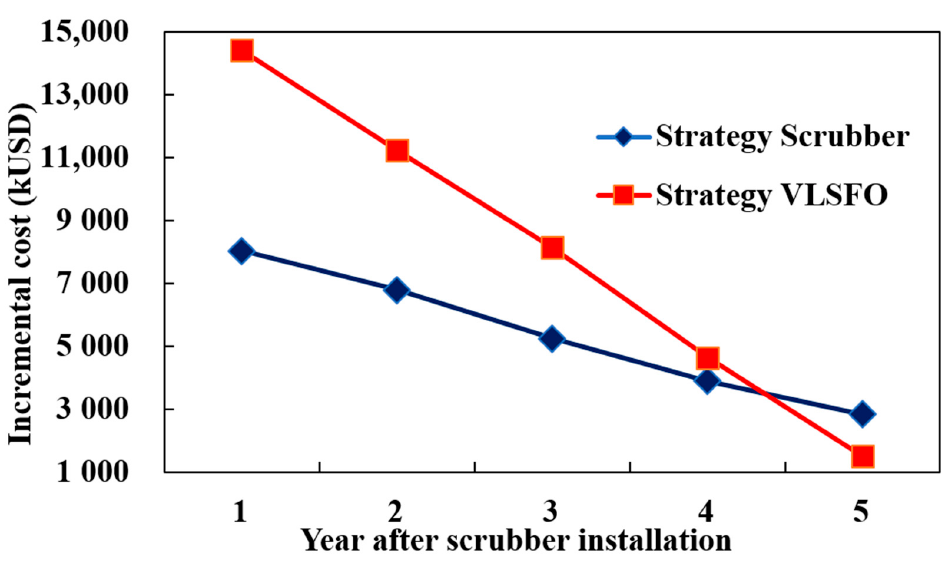
Figure 4. Total incremental costs in 1~5 years after Strategy VLSFO and Strategy Scrubber are im- plemented.